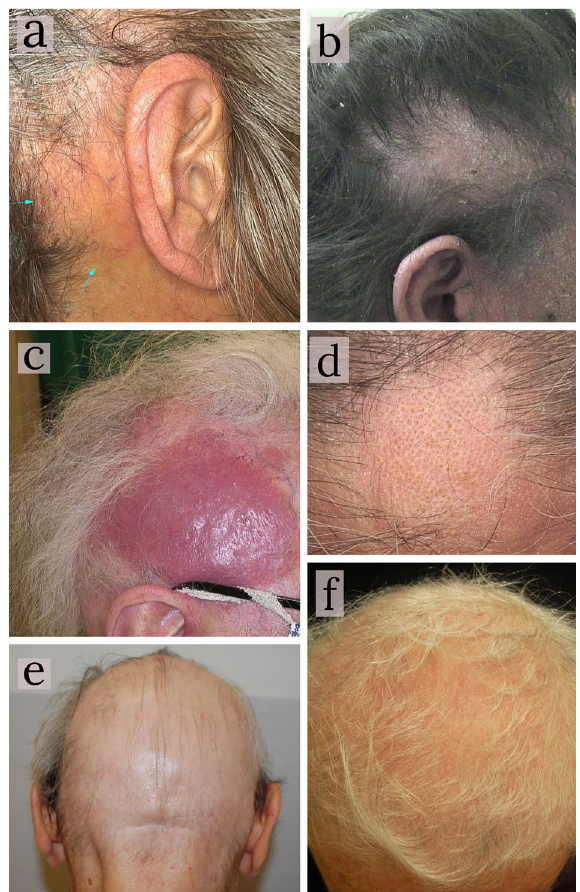
Figure 1. Different types of alopecia as clinical presentations of Folliculotropic Mycosis Fungoides involving the scalp. ( a ) retro-auricular erythematous patch alopecia; ( b ) scaly-erythematous patch alopecia; ( c ) erythematous plaque-nodular lesion in a patient with late Folliculotropic Mycosis Fungoides stage; ( d ) non- inflammatory frontal patchy alopecia; ( e ) generalized alopecia of the scalp in a male patient; ( f ) generalized alopecia of the scalp in a female